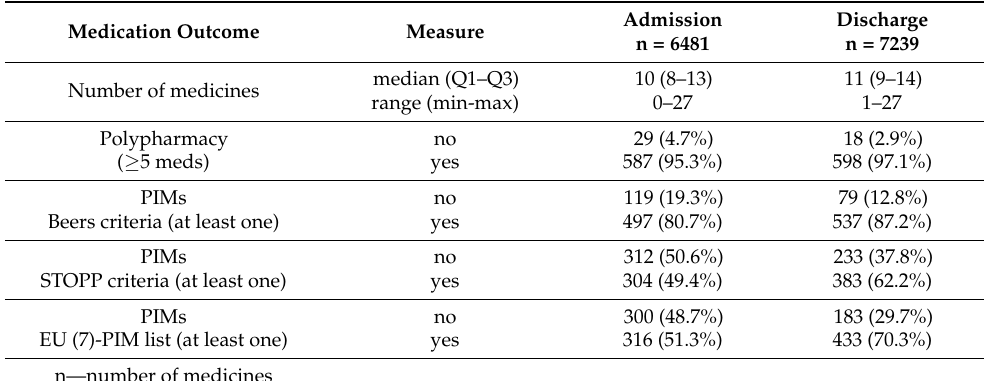
Table 1. Medications at admission and